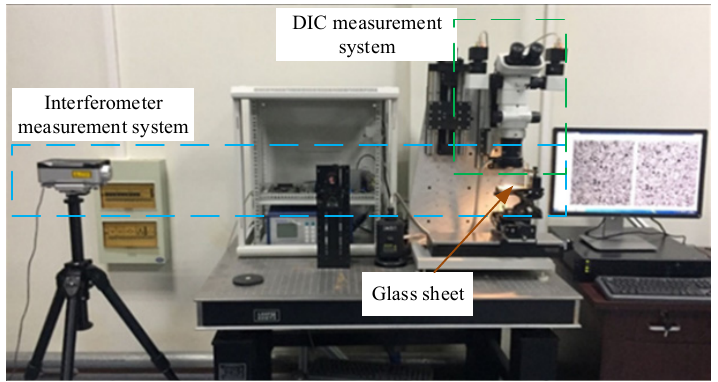
Figure 13. In-plane displacement measurement.